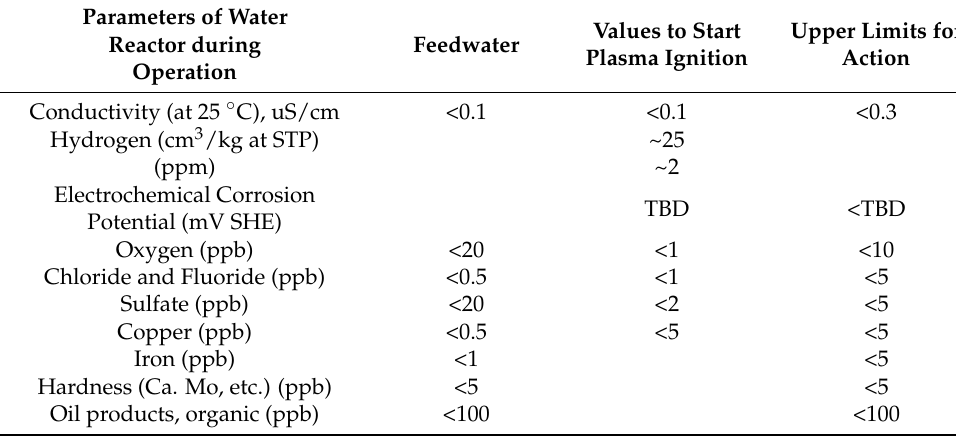
Table 13. Water chemistry parameters for the Divertor PHTS coolant